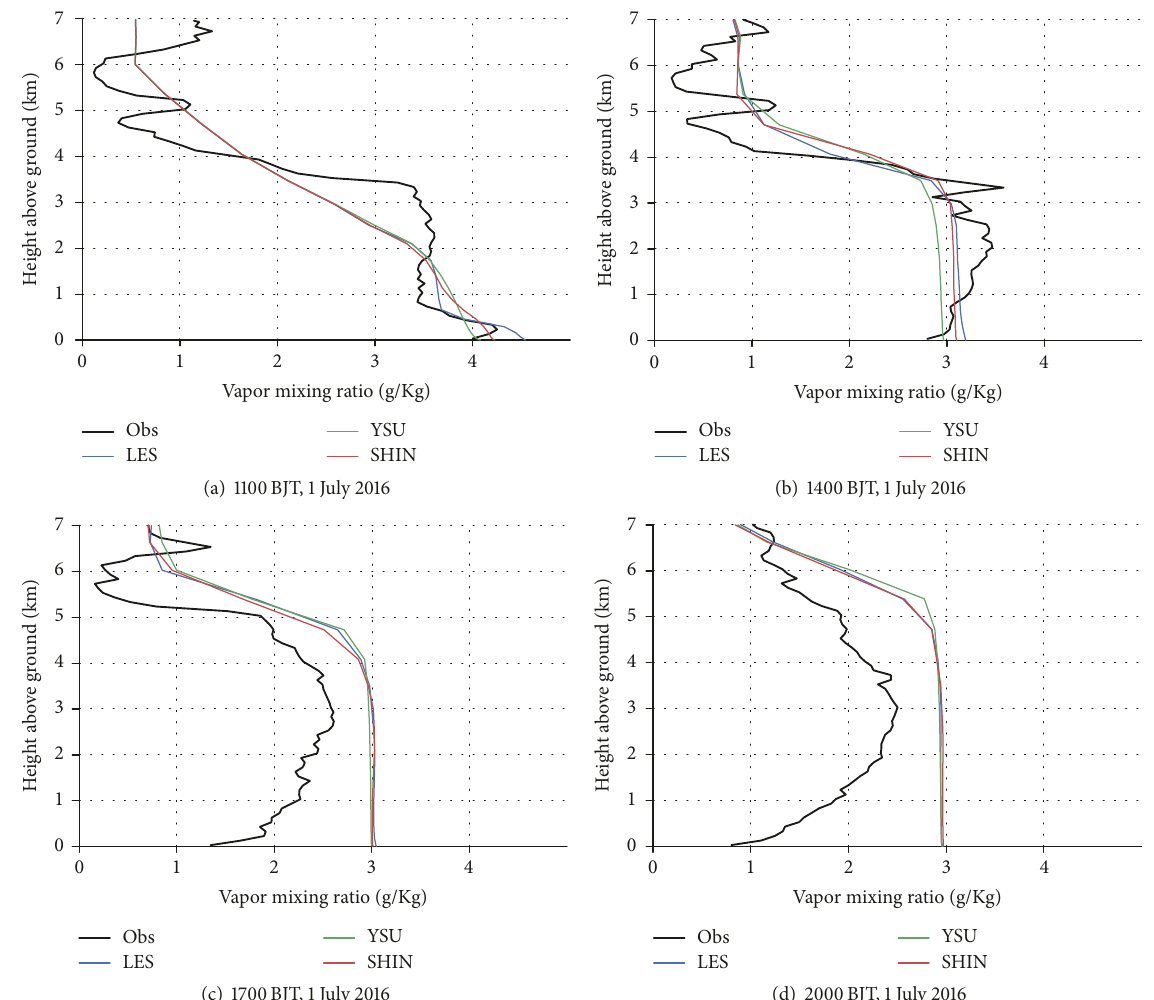
Figure 3: The same as Figure 2, but for vapor mixing